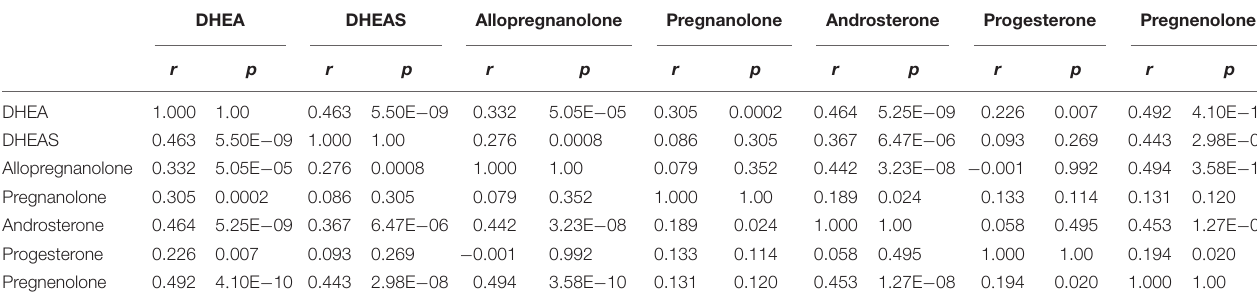
TABLE 9 | Cross-correlation table of neurosteroid levels. DHEA DHEAS Allopregnanolone